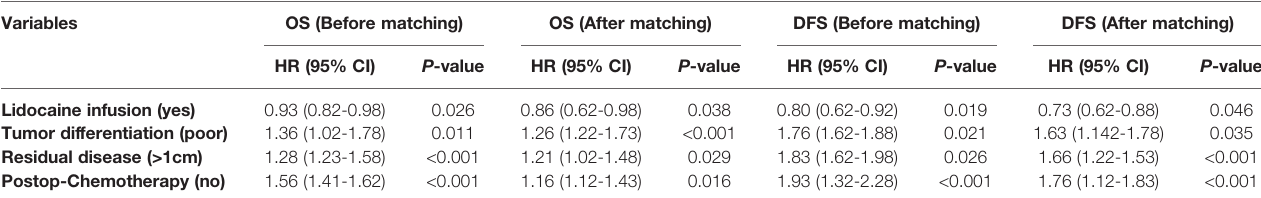
OS, Overall Survival; DFS, Disease free Survival.